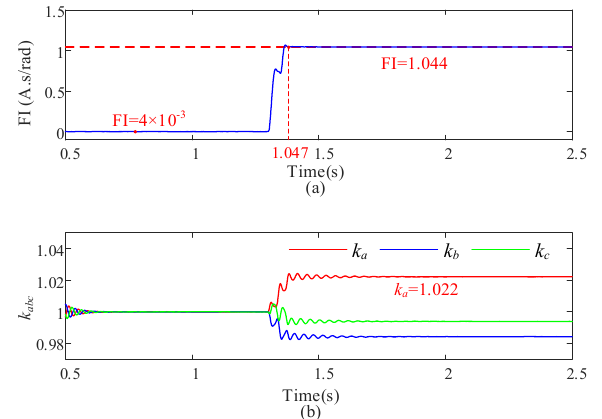
Figure 8. Simulation results of fault detection and fault location indexes. ( a ) Fault detection index; ( b ) fault phase location indexes.